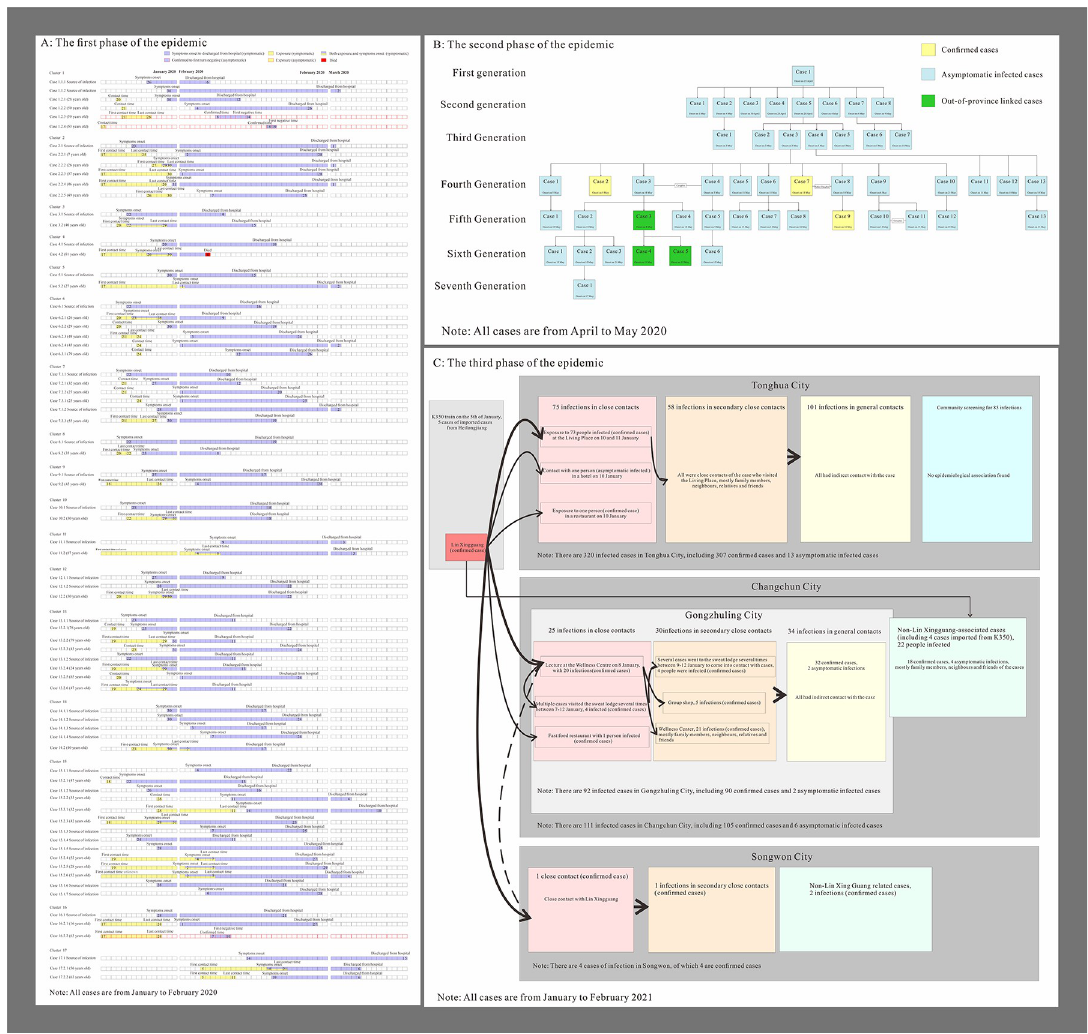
Fig 1. Three phases of COVID-19 outbreaks transmission mode in Jilin